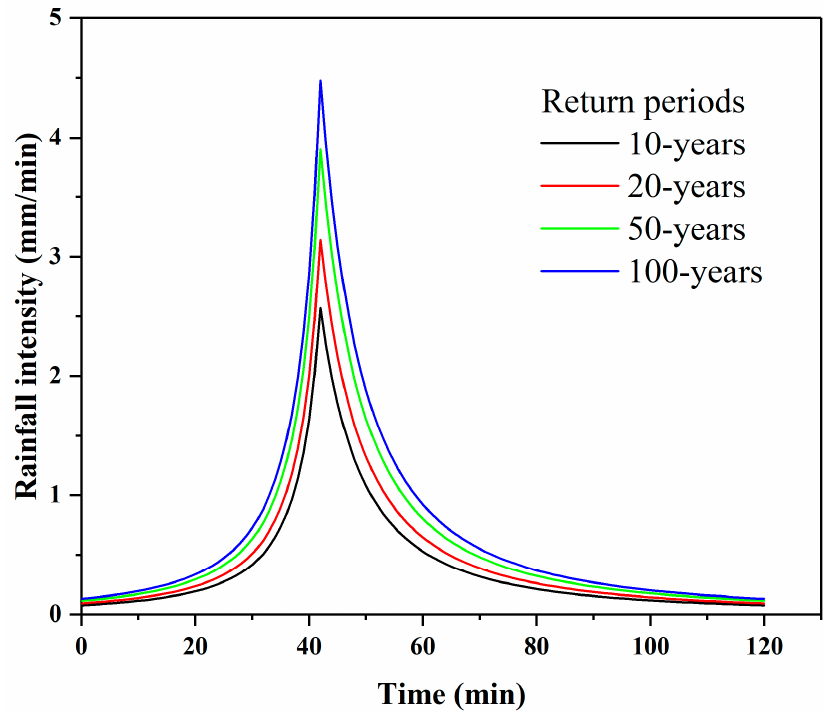
Figure 4. The different design hyetographs.